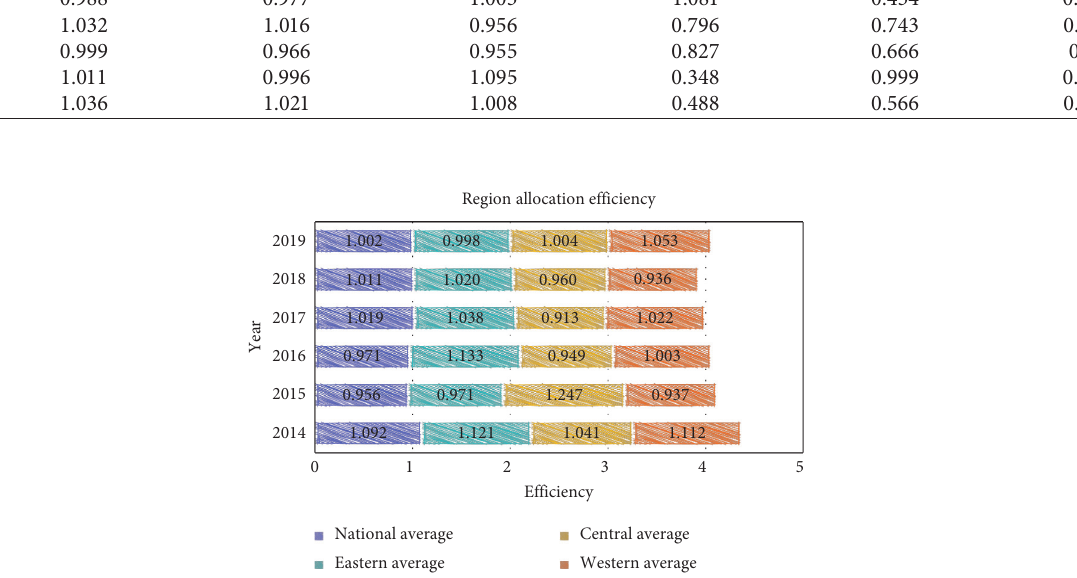
Figure 11: Changes in the efficiency of regional fiscal R&D resource